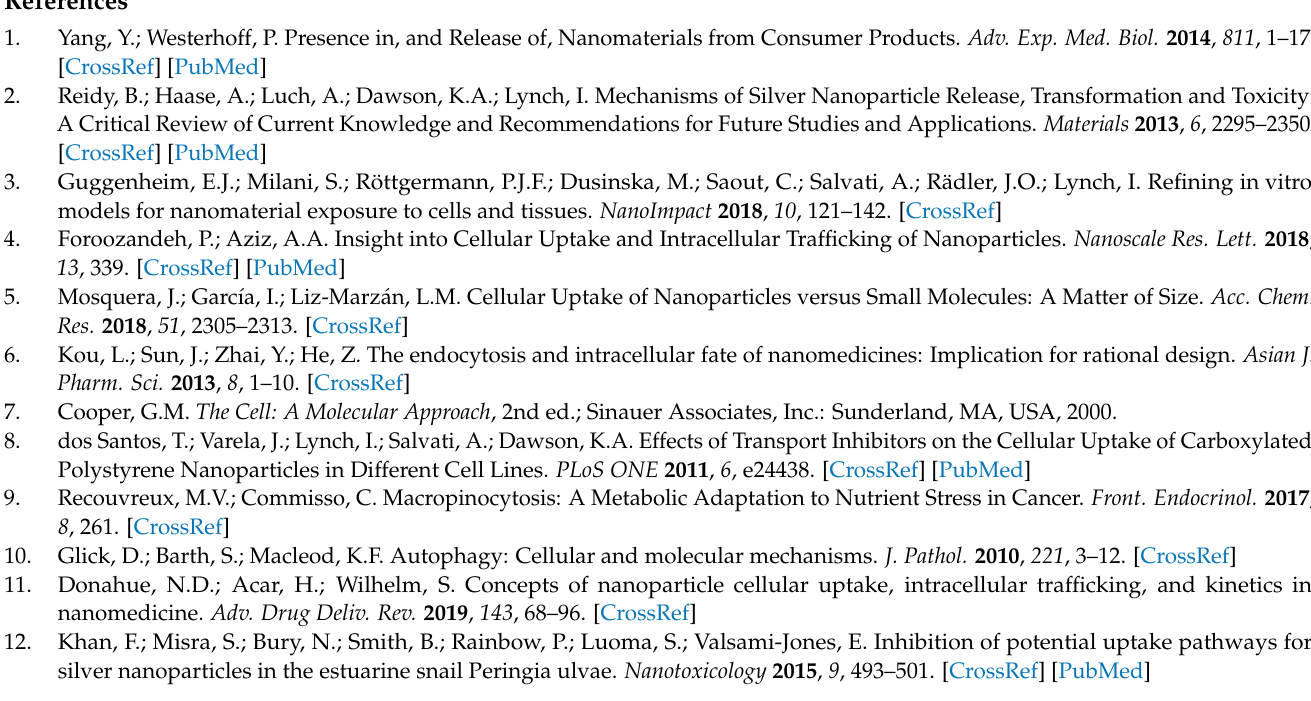
of the AgNPs. Figure S2. UV–vis images of the AgNPs. Figure S3. Analysis of intracellular AgNPs and vesicles. Table S2. Intracellular AgNP size determined by TEM. Table S3. Total Ag+ concentration per cell (pg/cell) determined by ICP–MS. Table S4. Inhibition of uptake pathways and resulting changes in AgNP uptake and internalisation. Table S5. Early endosome induction. Table S6. Autophagy results. Figure S4. Images of autophagy induction. Table S7. Analysis of the corona compositions. Figure S5. Coomassie blue staining of PAGE gels for isolated protein corona. Figure S6. Proteins secreted during AgNPs exposure in medium containing 10%